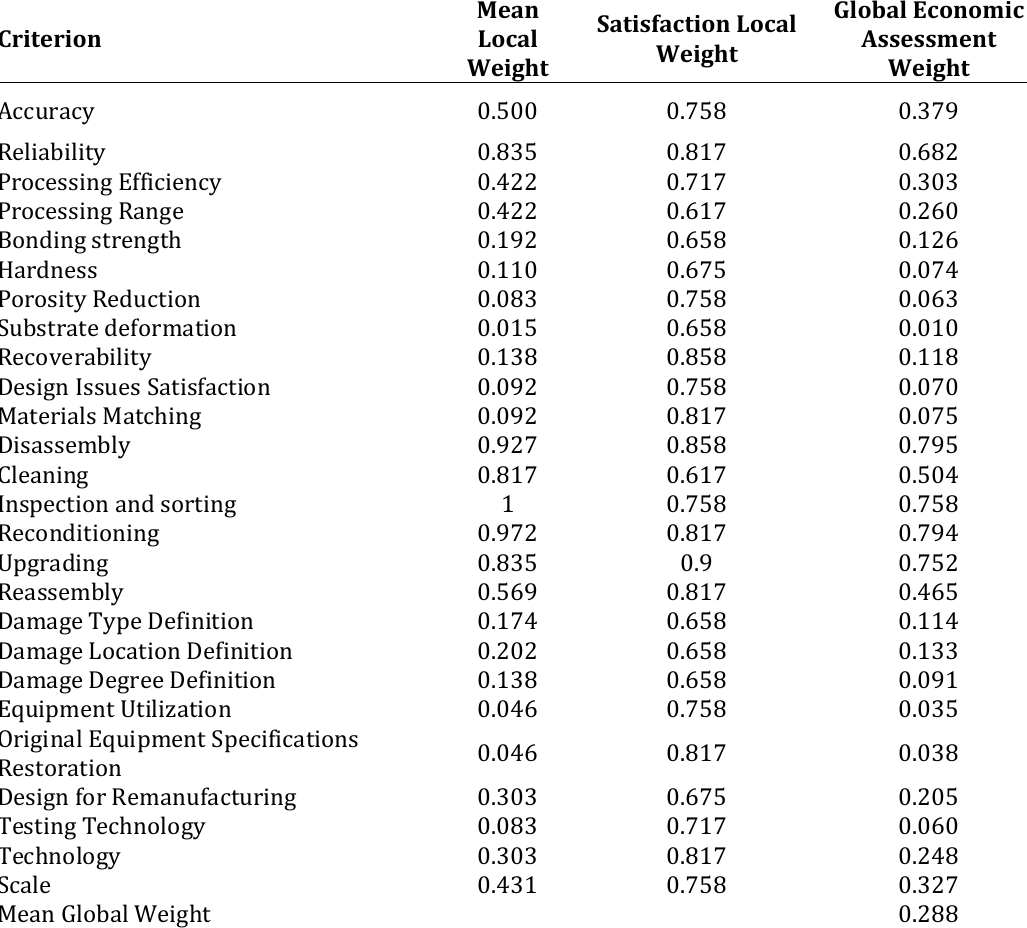
Table 7: Index weight and global weights of technical sub-sustainability assessment, micro-